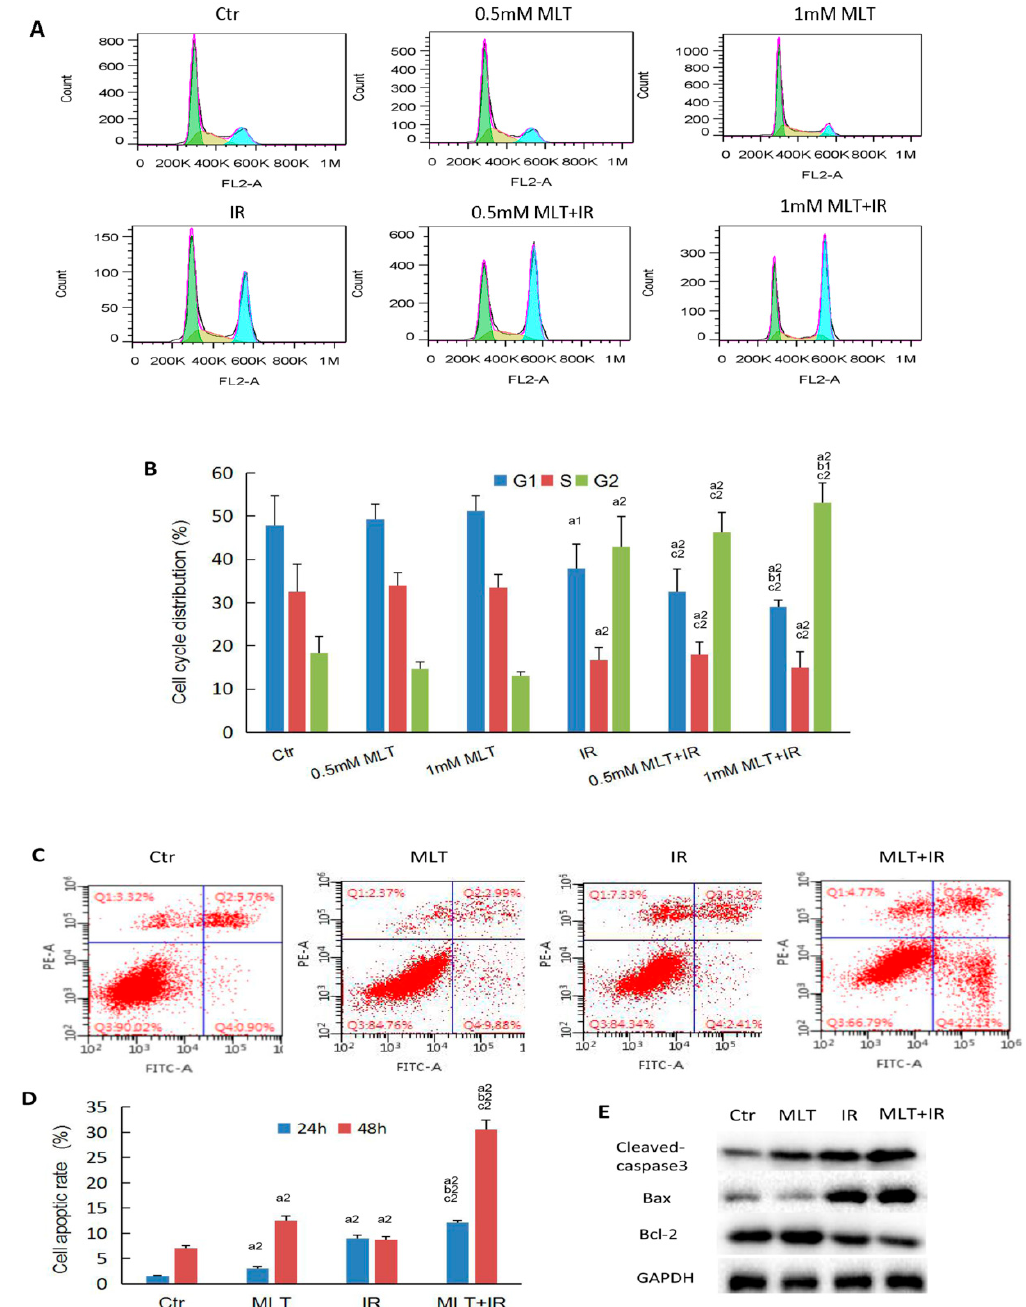
Figure 3. Melatonin-induced cell cycle redistribution and promoted apoptosis of the HCT 116 cells exposed to γ -ray radiation. ( A ) HCT 116 cells were treated with 0.5 mM or 1 mM melatonin for 2 h, then exposed to 6 Gy γ -ray radiation or not. The cell cycle distribution was examined after 24 treatment by flow cytometry. Representative images of cell cycle distribution are displayed; ( B ) the cell cycle distribution of HCT 116 was determined; ( C ) HCT 116 cells were treated with or without 1 mM melatonin for 2 h, then exposed to 6 Gy γ -ray radiation or not. The cell apoptosis was examined after 24 or 48 h treatment by flow cytometry. Representative images of cell apoptosis are displayed. Left lower quadrant denotes living cells, left upper quadrant denotes necrotic cells, right upper quadrant denotes late apoptotic cells, and right lower quadrant denotes early apoptotic cells; ( D ) the percentage of apoptotic cells was determined. Data are presented as the mean ± SD; ( E ) total protein was extracted after 2 h treatment and the levels of pro-apoptotic proteins, cleaved-caspase-3, Bax and anti-apoptotic protein Bcl-2 were detected by Western blot analysis. a1 p < 0.05; a2 p < 0.01 vs. control, b1 p < 0.05; b2 p < 0.01 vs. IR, c2 p < 0.01 vs.